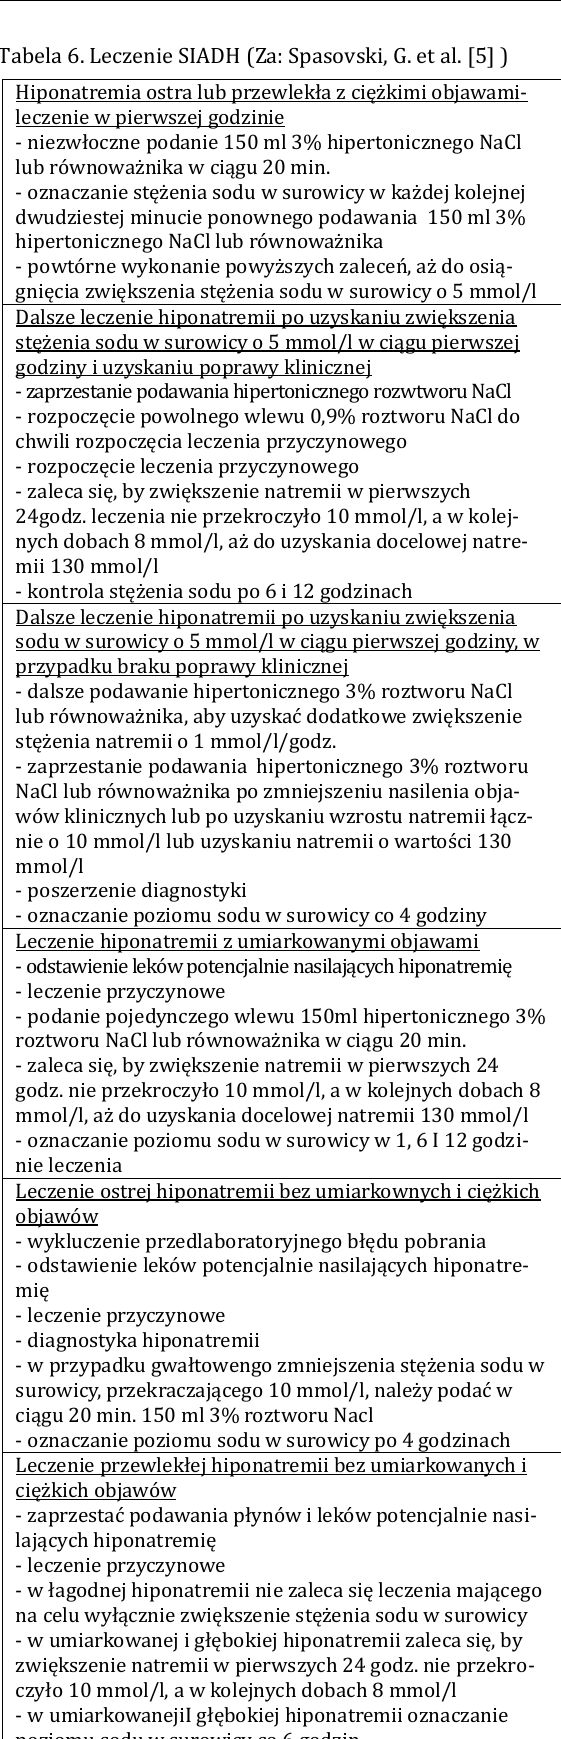
Tabela 6. Leczenie SIADH (Za: Spasovski, G. et al. [5] ) Hiponatremia ostra lub przewlekła z ciężkimi objawami- leczenie w pierwszej